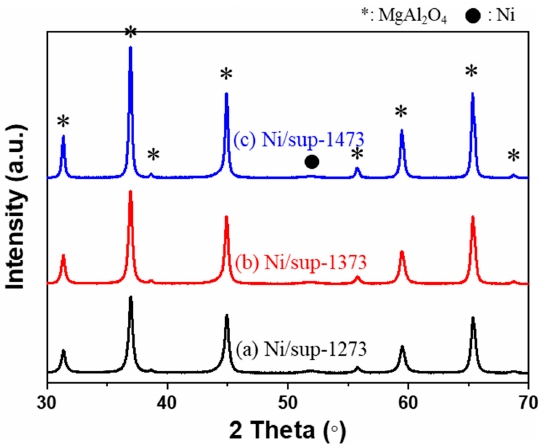
Figure 5. XRD patterns of the egg-shell-type 3.5 wt% Ni/MgAl 2 O 4 pellet catalysts.